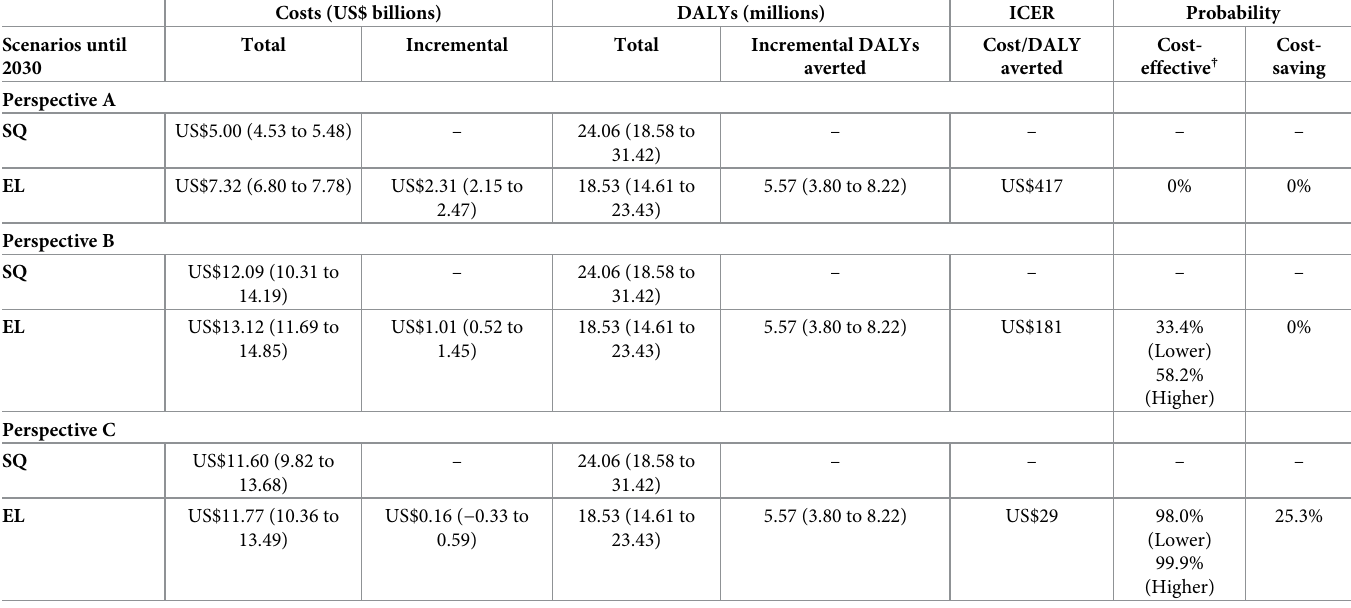
Table 4. ICERs for the modelled EL scenario over 2018–2030 for 3 economic perspectives. Costs and DALYs are discounted at 3.5% per annum. Perspective A includes direct costs only (costs for testing, treatment, and healthcare management). Perspective B includes direct costs (perspective A) plus productivity costs. Perspective C includes partially integrated direct costs and productivity costs. The values represent the median and 95% UIs across 1,151 model